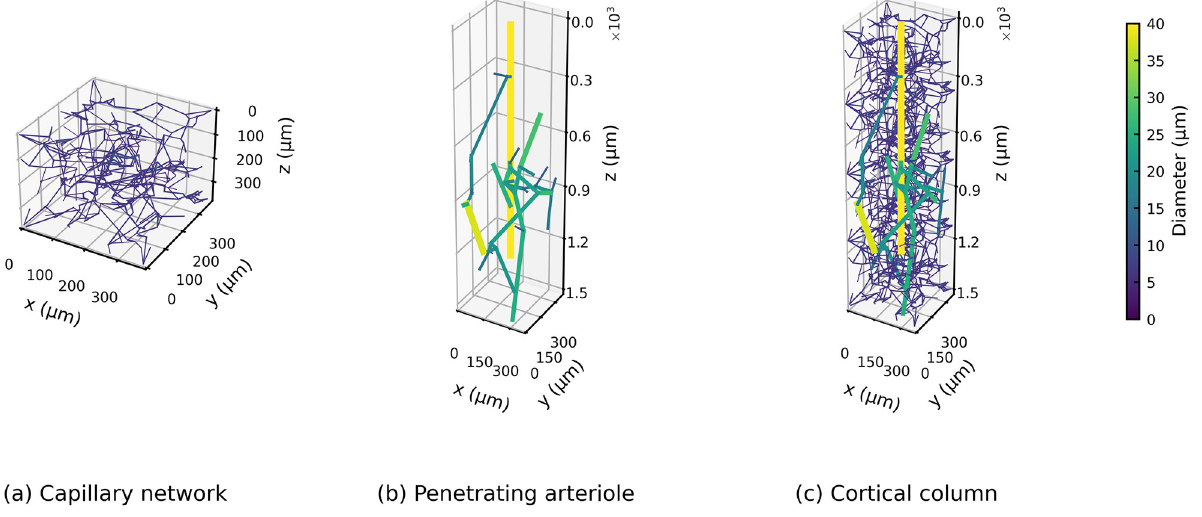
Fig 2. Geometry of (a) a capillary network, (b) a penetrating arteriole and (c) a cortical column built from the penetrating arteriole and the capillary cubes.